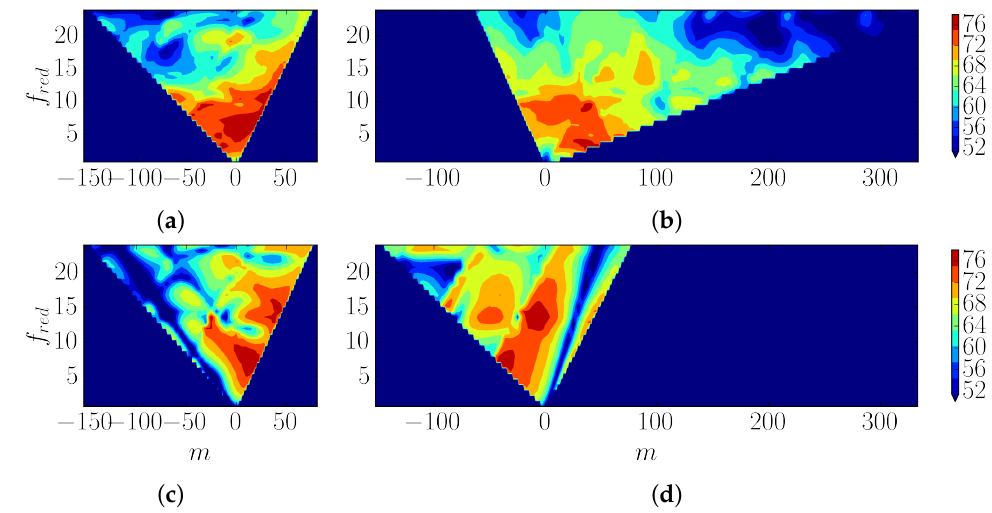
Figure 5. NSPL modal decomposition accounting for the actual geometry and for the equivalent flat plate cascade as a function of the azimuthal mode index. ( a ): Airfoil Geometry-Inlet; ( b ): Airfoil Geometry-Outlet; ( c ): Flat Plate Geometry-Inlet; ( d ): Flat Plate Geometry-Outlet.The scale is saturated below the lower limit for enhanced